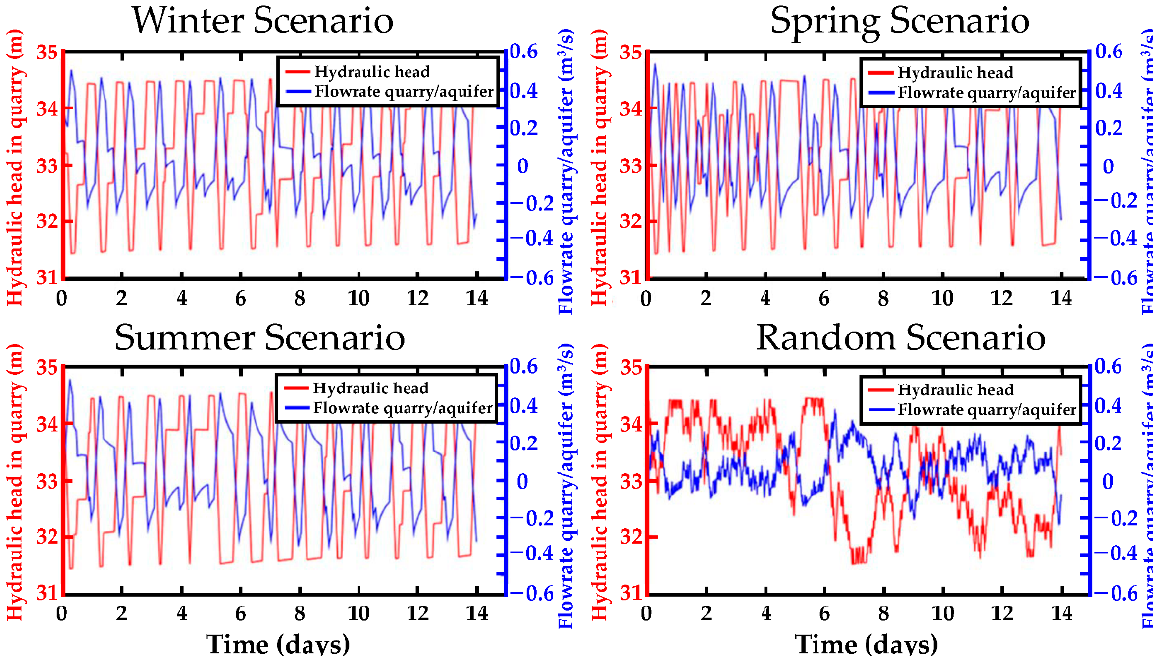
Figure 6. Hydraulic head variations in the quarry (red line) and flowrate exchange between the quarry and the chalk aquifer (blue line). Positive and negative values for the exchange flowrate relate to groundwater that flowed towards the quarry and water that flowed from the quarry to the chalk aquifer, respectively.